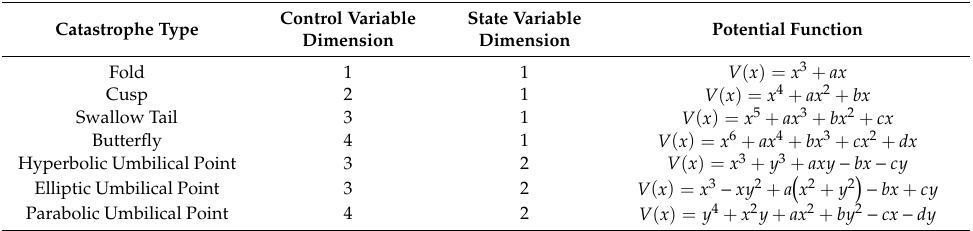
Table 1. The seven primary catastrophe